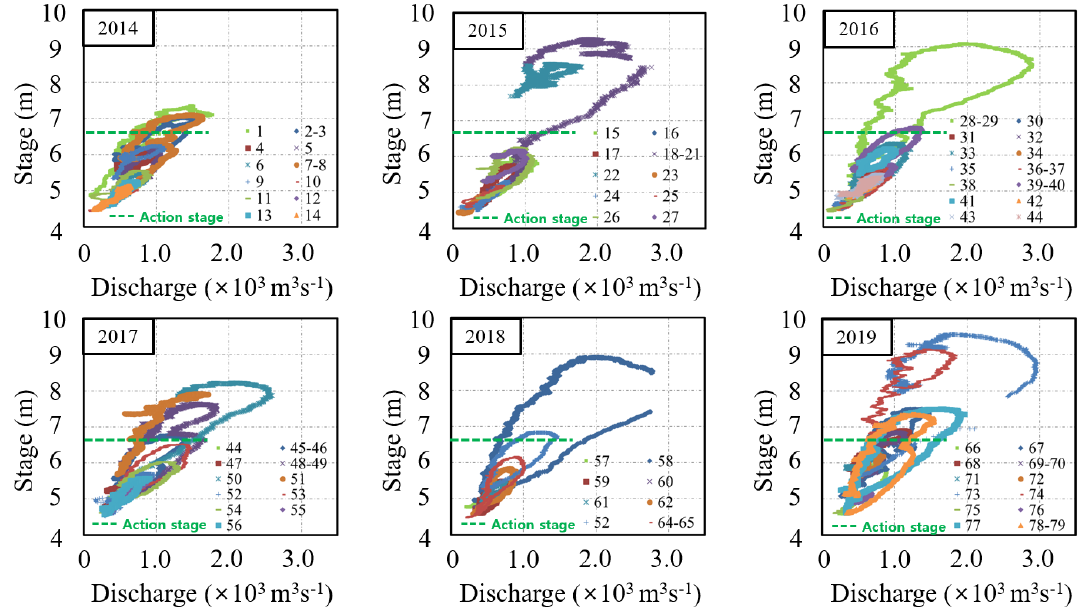
Figure 4. Time-independent stage-discharge relationships for the major storms that occurred during the observation period.